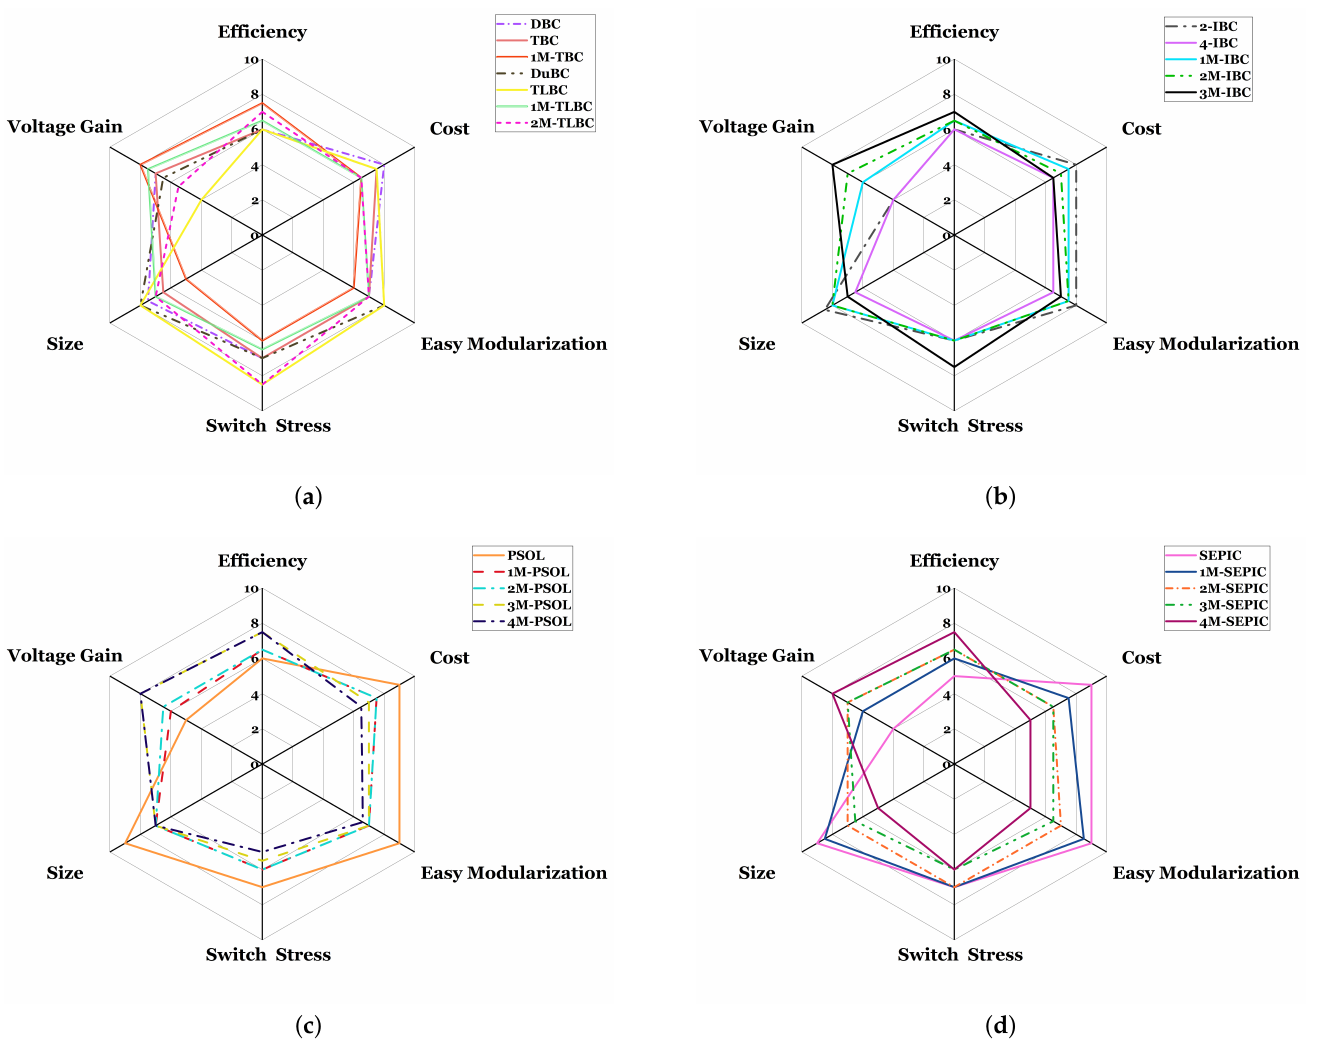
Figure 30. Radar Chart for Summarize Comparison ( a ) Group 1 (DBC, TBC, 1st M-TBC, DuBC, TLBC, 1st M-TLBC, and 2nd M-TLBC) ( b ) Group 2 (2-IBC, 4-IBC, 1st M-IBC, 2nd M-IBC, and 3rd M-IBC) ( c ) Group 3 (PSOL, 1st M-PSOL, 2nd M-PSOL, 3rd M-PSOL, and 4th M-PSOL) ( d ) Group 4 (SEPIC, 1st M-SEPIC, 2nd M-SEPIC, 3rd M-SEPIC, and 4th